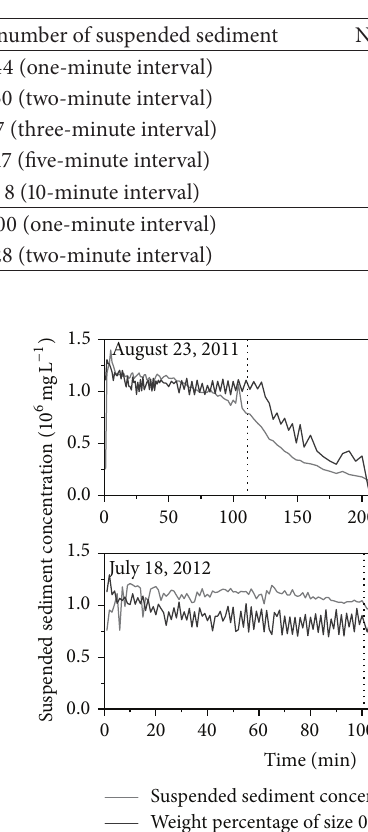
Table 1: Sampling number and duration of the two flood events in the Sudalaer desert stream.